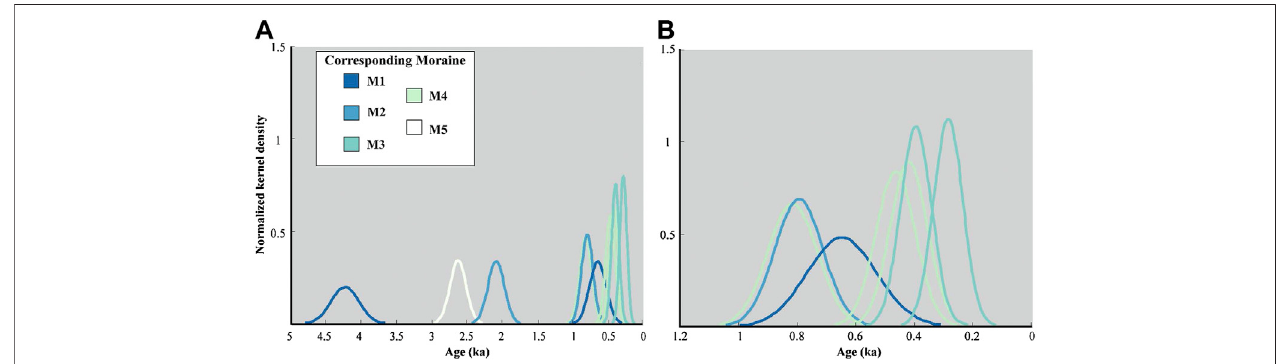
FIGURE 7 | Panel (A) Normalized kernel density estimates for all samples. Panel (B) Normalized kernel density estimates for samples that fall within the Southern Hemisphere expression of the Little Ice Age. Sample ages in both panels are plotted with internal analytical uncertainties.